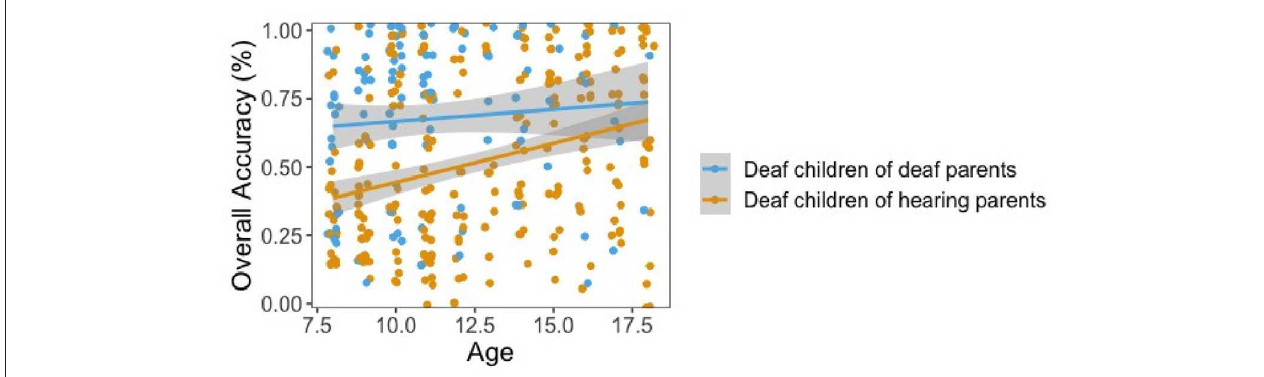
FIGURE 4 | The proportion of the questions answered correctly as a function of age and parental hearing status. Points were jittered slightly to avoid overlap.